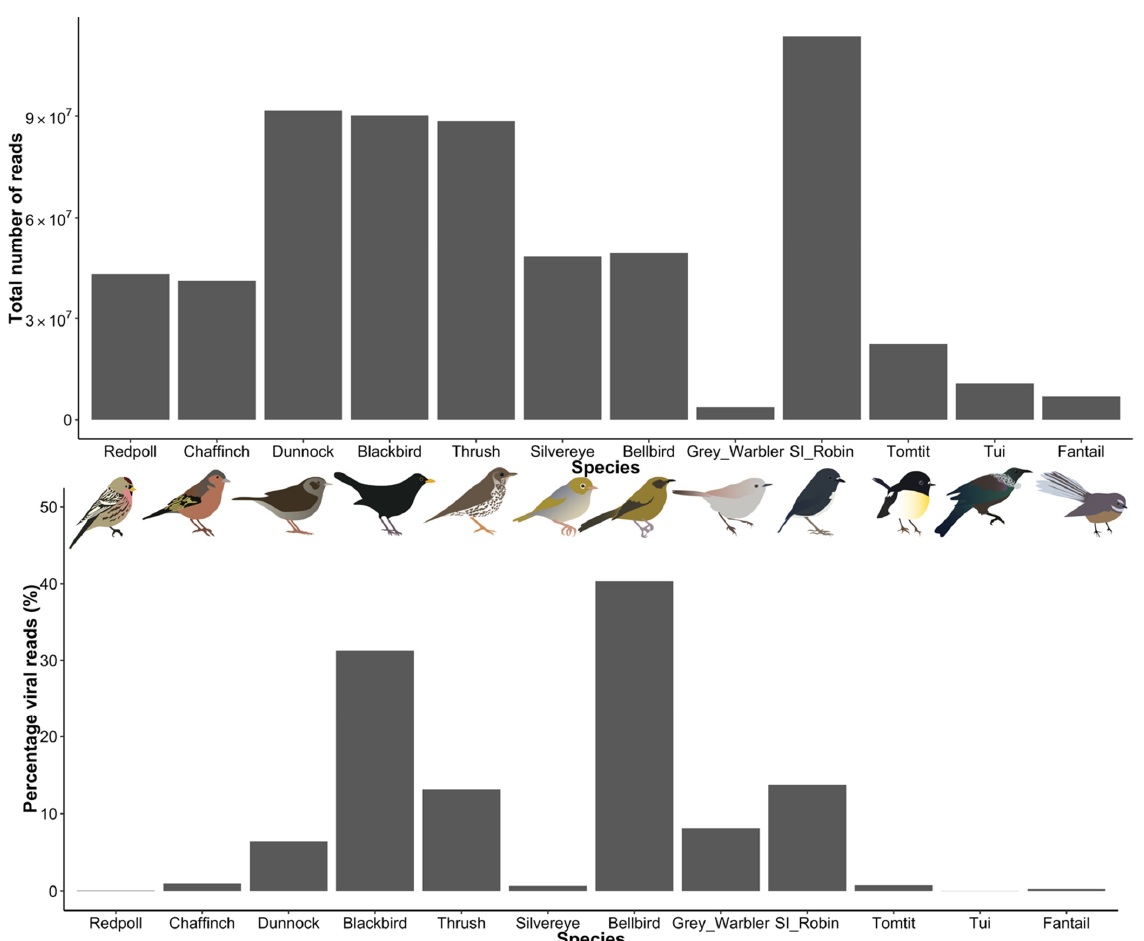
Figure 2. Read counts and the percentage of viral reads (%) for libraries from 12 New Zealand bird species. Bird images by Michelle Wille. Table 2. The alpha diversity of each species/library—the richness (number of species), Shannon index and Simpson index, and the predominant diet of each